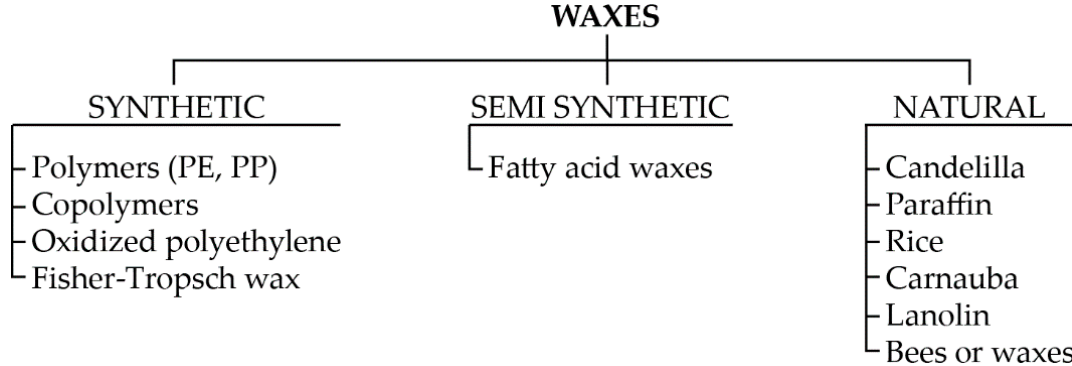
Figure 1. Division scheme of waxes.